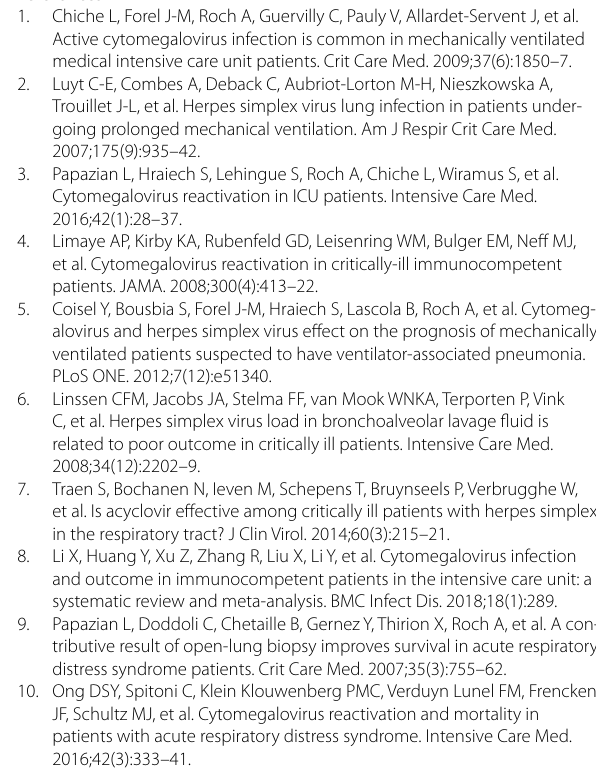
Additional file 1: Table S1. Clinical outcomes according to anti‑viral